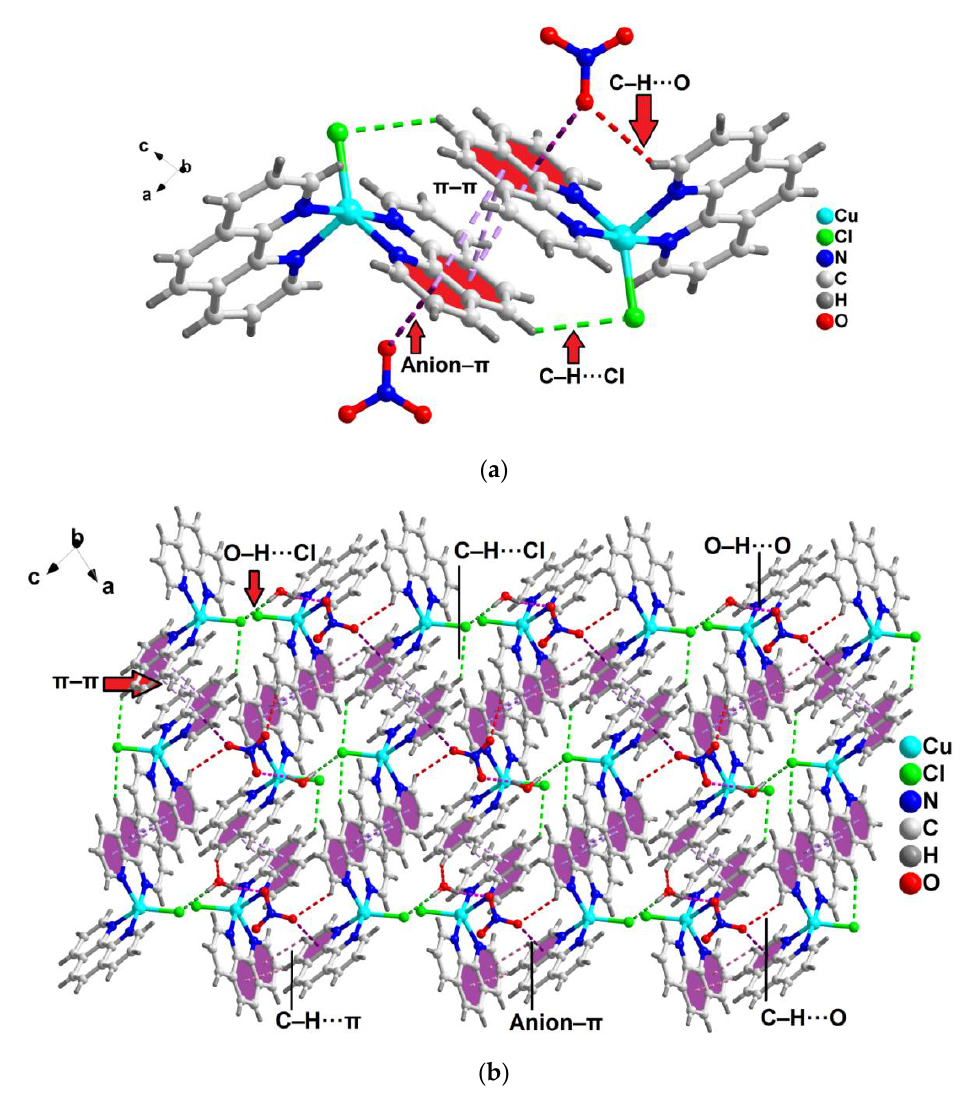
Figure 2. ( a ) Formation of the anion– π / π – π / π –anion assemblies in compound 1 involving the uncoordinated nitrate anions. ( b ) Layered assembly of compound 1 along the crystallographic ac plane aided by the anion– π / π – π / π -anion